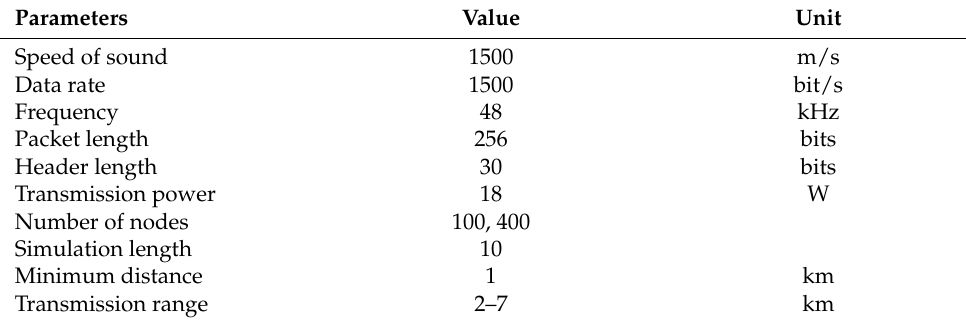
Table 9. Parameters of